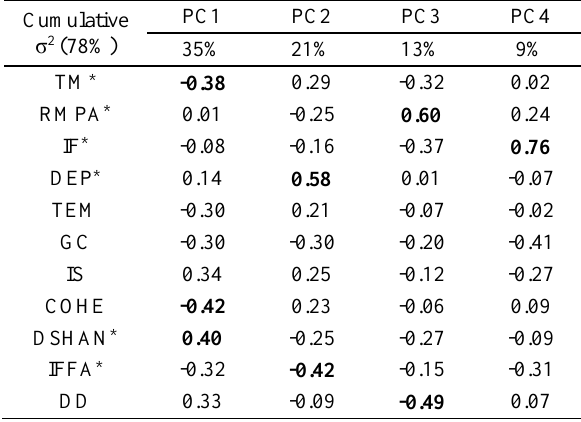
Table 3. Results of principal component analysis (PCA) at FUA level. The first four components (PC) with eigenvalues higher than one are shown, along with partial and cumulative variances (σ 2 ) represented. Values in bold correspond to the highest loadings of each component. Indices with * are included in the final metrics subset